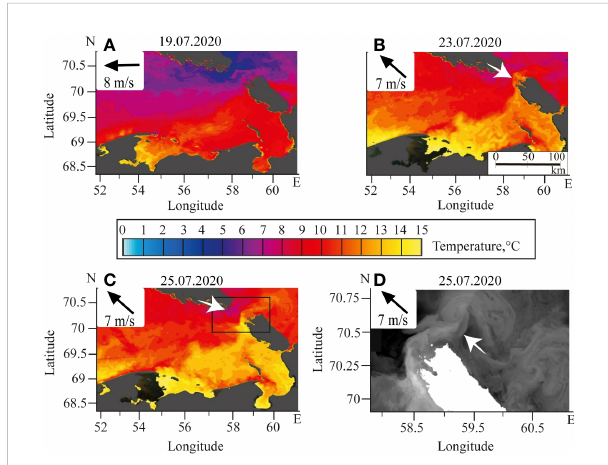
FIGURE 10 Satellite-derived Sea surface temperature in the Pechora Sea on 19 July (A) , 23 July (B) , 25 July (C, D) 2020 acquired by NOAA-20/VIIRS (A-C) and Landsat-8 (D) . In fl ows of the Pechora plume to the Kara Sea through the Kara Strait are indicated by white arrows. Black rectangle in panel (C) indicates location of the zoomed area shown in panel (D) . Dark grey color at panels (A-C) and white color at panel (D) indicate land; white color at panels (A-C) indicates cloud coverage of the study area. Wind direction and velocity averaged during two days preceding the satellite image are shown in the insets.